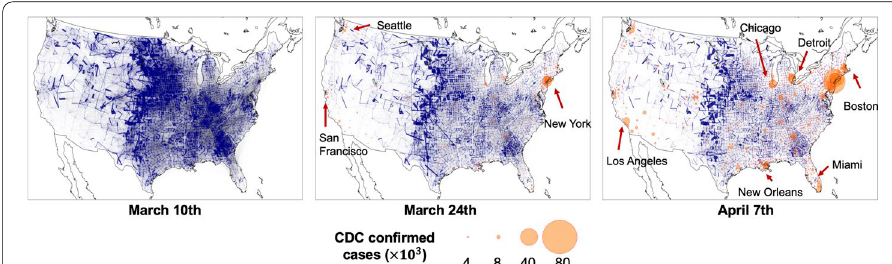
Fig. 1 Population co-location probability among US counties. A node represents a county; an edge represents the co-location relationship between two counties. The size of a node is proportional to the number of confirmed cases in a county; the width of an edge is proportional to the co-location probability of two